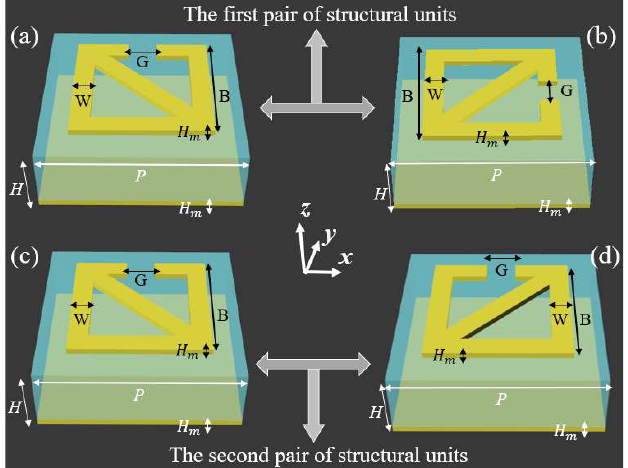
Figure 1. Schematic illustration of two pairs of structural units for tunable selective absorption of different polarized waves. ( a ) and ( b ) are the pair of structural units for tunable selective absorption of linear polarized waves. ( c ) and ( d ) are the pair of structural units for tunable selective absorption of circularly polarized waves. The schematic diagram of two pairs of structural units for tunable selective absorp- tion with different polarizations is shown in Figure 1, which is intuitively represented in the Cartesian coordinate system (x, y, z ) . Here, the yellow part represents aluminum, and the cyan part represents polymide. All structural units are sandwich structures composed of aluminum-polymer-aluminum patterns. The top layer is the aluminum pattern, the middle layer is the polymide, and the bottom layer is the metal aluminum sheet. The first pair of structural units was designed to achieve high-contrast near-field imaging of linear polarized waves. The second pair of structural units was designed to achieve high-con- trast near-field imaging of circularly polarized waves, which means very large circular dichroism. The two pairs of structural units were complementary, respectively. We used the finite element method (FEM) to carry out a lot of simulation optimization, so the phys- ical parameters of the structural unit are determined as shown below: W = 10 μm, G = 40 μm, B = 120 μm, H m = 0.3 μm, H = 40 μm, P = 160 μm. The conductivity of aluminum is 3.72 × 10 7 S ∕ m, the dielectric constant of the polymide is 3.5 and the loss tangent value is 0.0027. The VO 2 follows the Drude model [25].